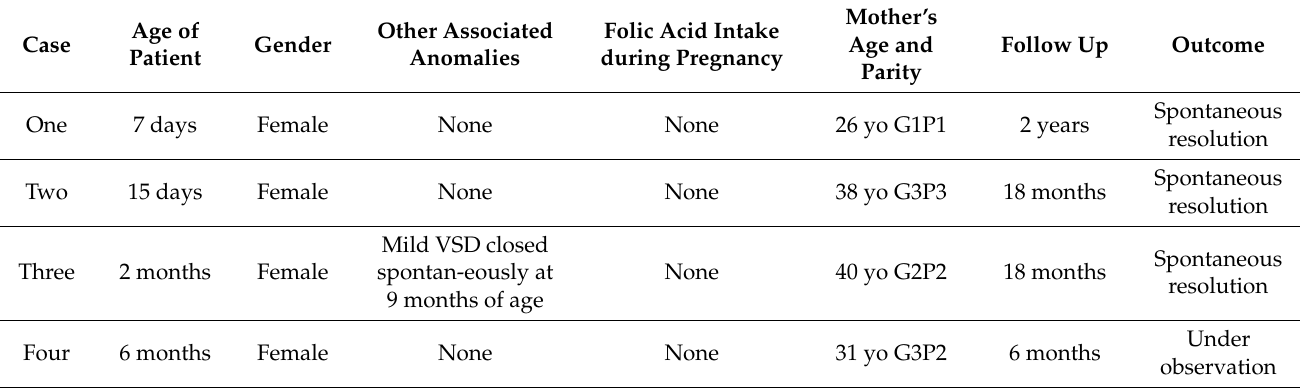
Table 1. Demographic data of 4 cases.